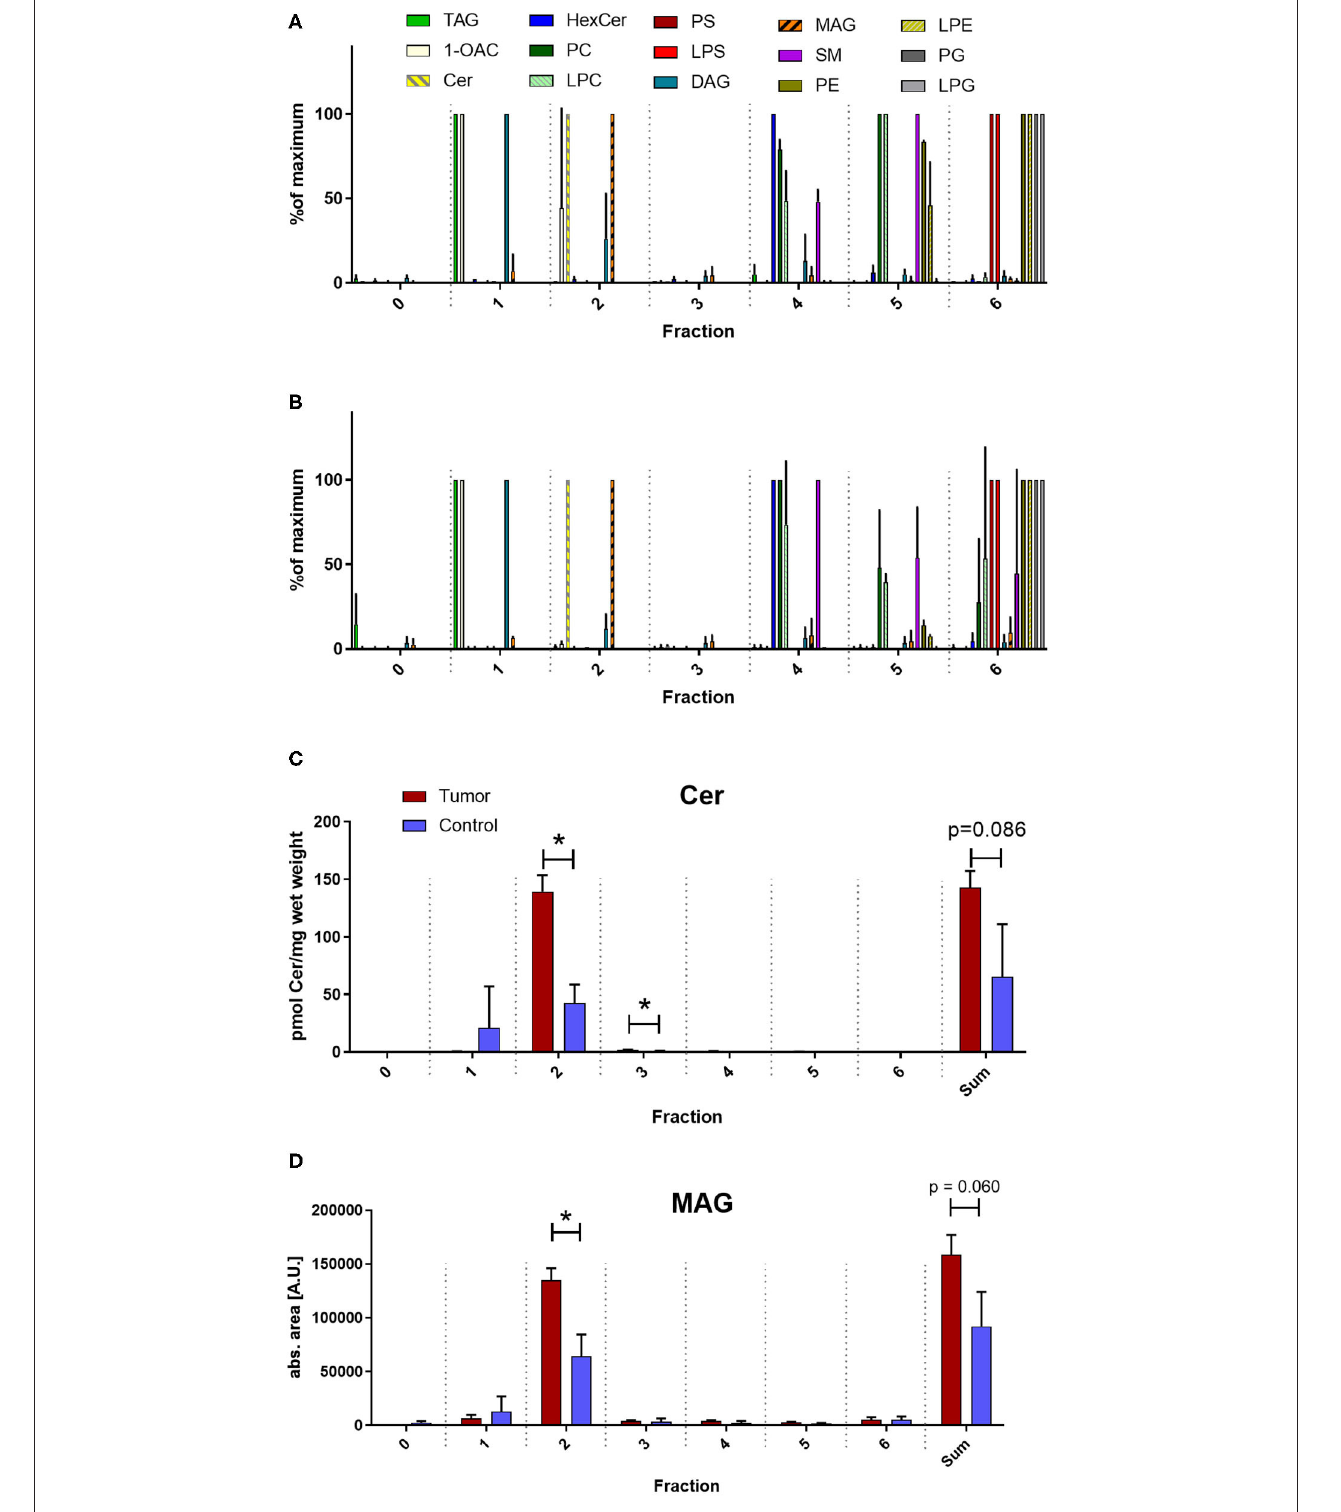
FIGURE 5 | Lipid profile of fractionated tumor lipids. Lipids of tumor samples 277 (A) and 288 (B) and three normal kidneys ( Supplemental Figure 5 ) were fractionated on aminoproyl column as described in the methods section and fractions were screened for several lipid classes by reversed phase LC-MS 2 . Note, that